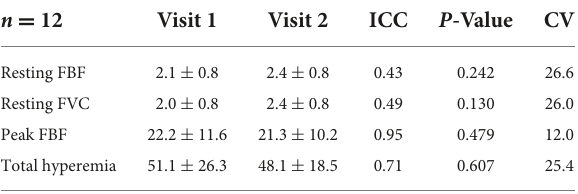
TABLE 2 Reliability (2,1 model; ICCs), systematic error (repeated measures ANOVA).